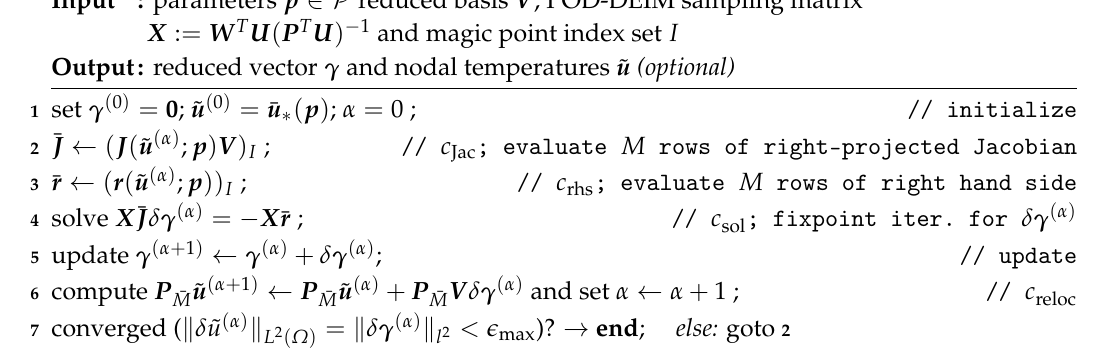
Algorithm 5: Online Phase of the Discrete Empirical Interpolation Method